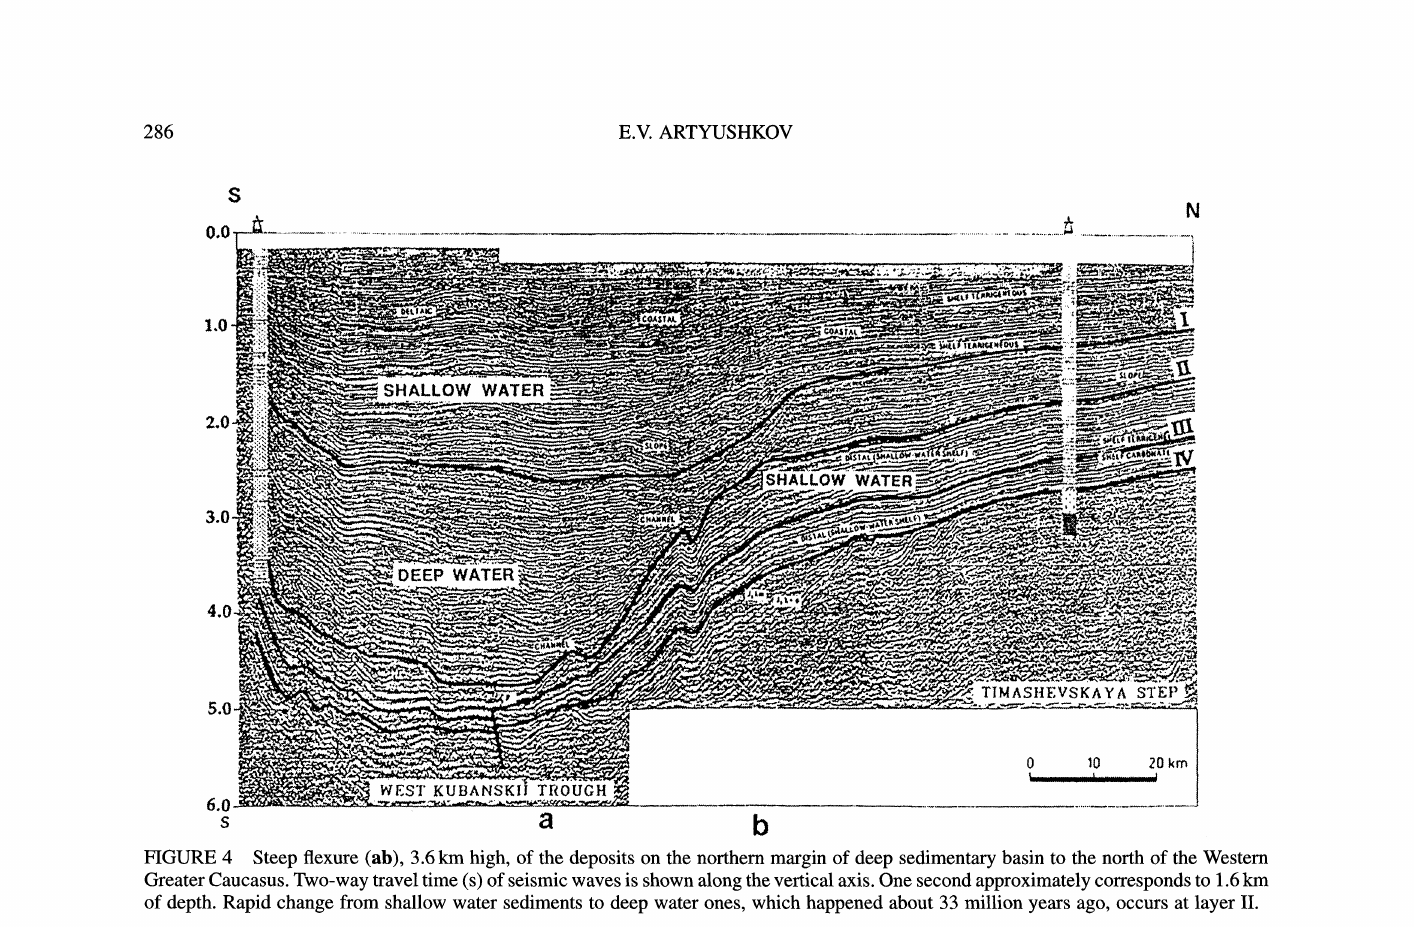
FIGURE 4 Steep flexure (ab), 3.6 km high, of the deposits on the northern margin of deep sedimentary basin to the north of the Western GreaterCaucasus. Two-way travel time (s) of seismic waves is shown along the vertical axis. One second approximately corresponds to 1.6 km of depth. Rapid change from shallow water sediments to deep water ones, which happened about 33 million years ago, occurs at layer II.